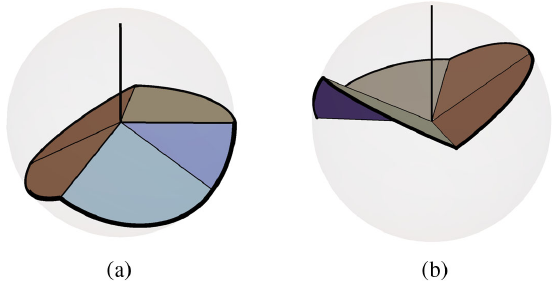
FIG. 5. (a) A five-fold origami vertex in a popped up configu- ration; the vertical line depicts the “ upwards ” normal of the origami surface. (b) The same vertex in a popped down